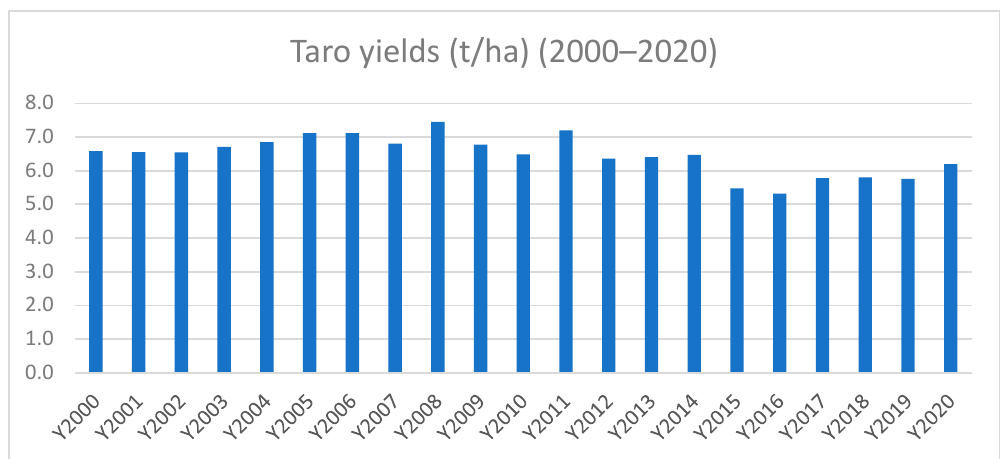
Figure 2. Taro yield in Africa from 2000 to 2020 (FAOSTAT, 2022).